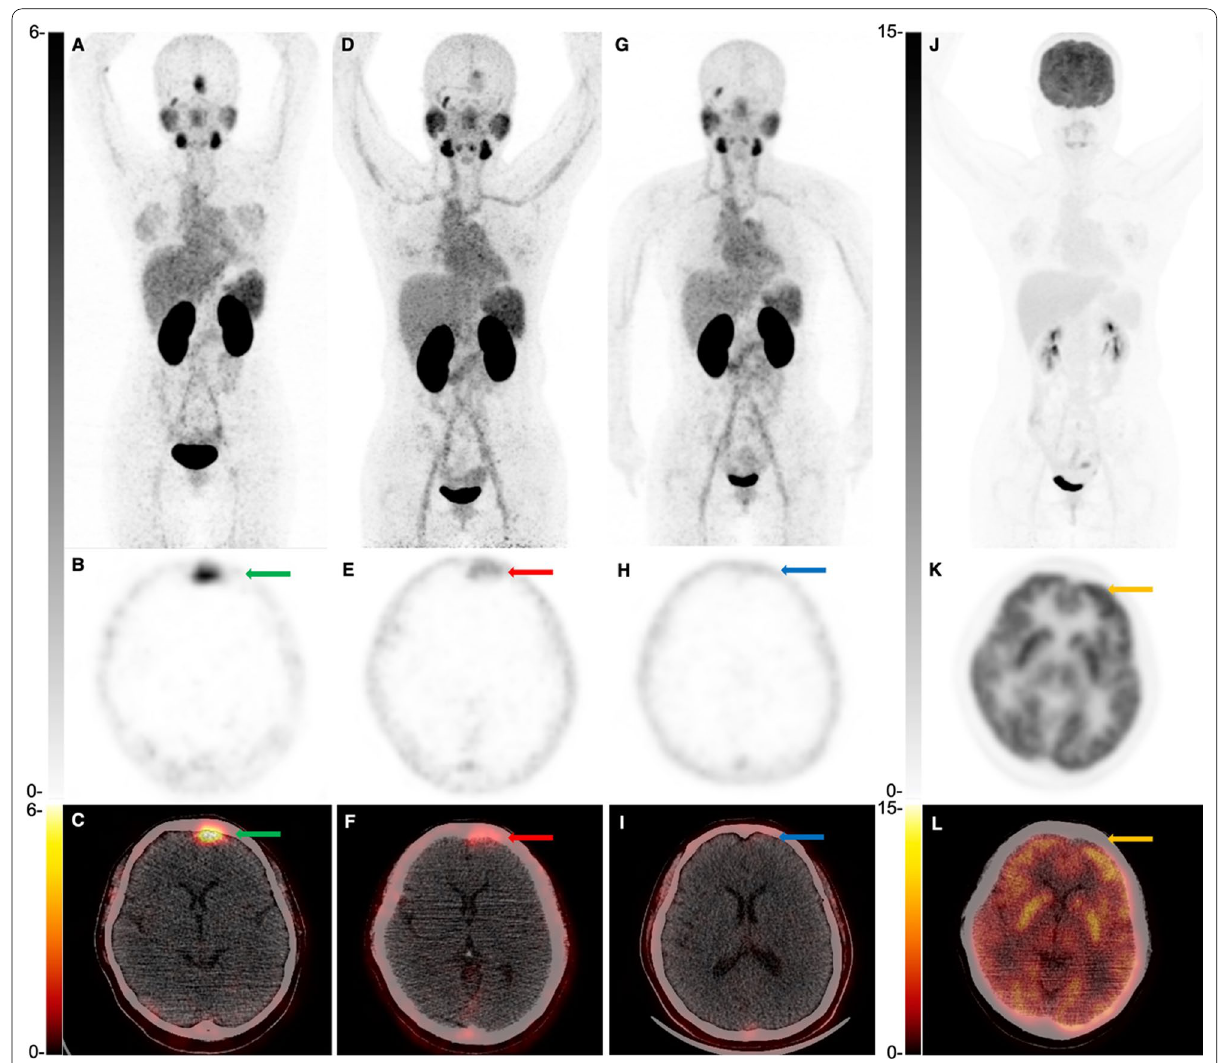
Fig. 5 A 41-year-old female patient was diagnosed with a left frontal meningeal metastasis 20 months after surgical removal of the left lacrimal gland ACC. Pre-therapy 68 Ga-PSMA-617 PET/CT ( A – C ) demonstrated intense PSMA uptake of tumor (green arrow, SUVmax 7.0). 68 Ga-PSMA-617 PET/CT reexamination at 9 weeks after the 1st cycle of PSMA RLT ( D – F ) and 8 weeks after the 3rd cycle of PSMA RLT ( G – I ) revealed significantly decreased tracer uptake of tumor (red arrow, SUVmax 3.5; blue arrow, SUVmax 1.1), which reached the level of CR according to modified PERSIST criteria. However, 18 F-FDG PET/CT ( J – L ) always exhibited no positive lesions (orange